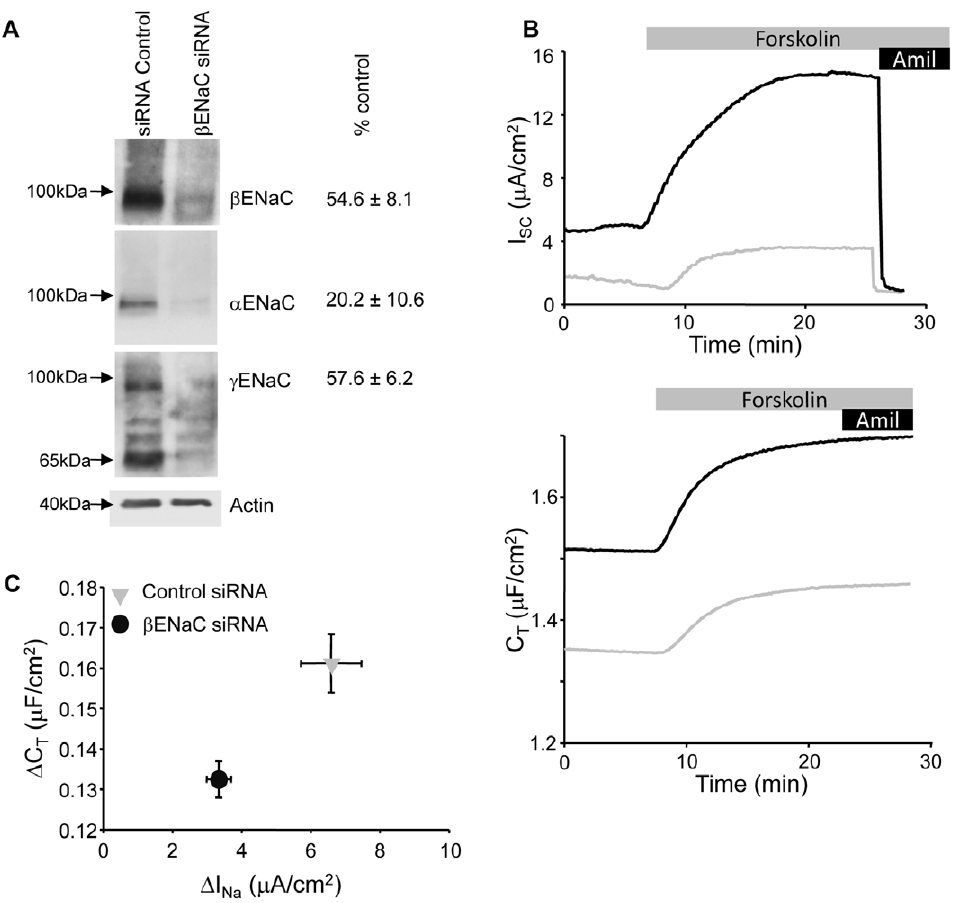
Figure 3. ENaC siRNA reduces I SC and cAMP C T response. (A) Western blots of whole cell lysate from b ENaC knockdown demonstrate reduction in expression of ENaC compared to control siRNA transfected mpkCCD cells. The actin-corrected percent reduction in expression (n=3) are summarized to the right of each representative blot. (B) Representative traces for I SC (top traces) and C T recordings (bottom) for control (black traces) and ENaC knockdown (grey traces) cells stimulated with forskolin (10 m M). (C) Summarized data for I SC versus C T responses to forskolin stimulation for control (n=45) and b ENaC (n=55) knockdown cells similar to those presented in (B).